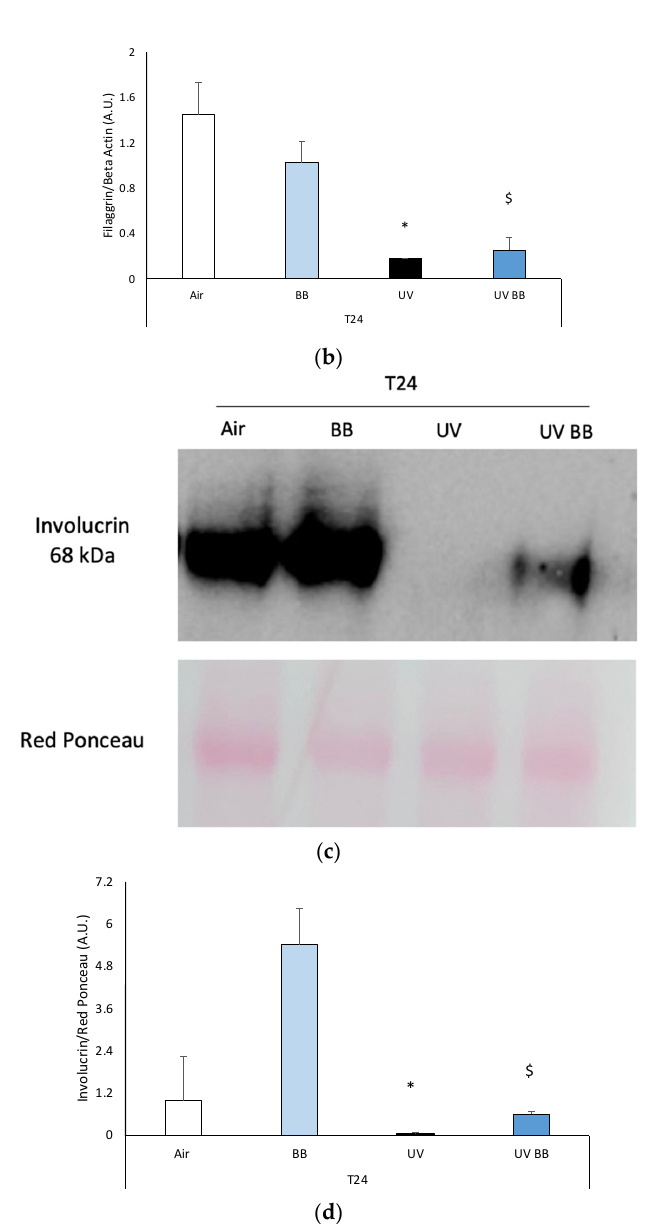
Figure 5. Skin exposure to UV impairs skin barrier functions (filaggrin, involucrin), which were normalized by the pre-treatment with BB extract. Ex vivo human skin biopsies were untreated or pre-treated with BB and then exposed to 200 mJ of UVA/UVB, then, filaggrin and involucrin protein levels were evaluated. ( a ) Filaggrin protein levels measured via Western blot assay at 24 h (T24) upon UV exposure. ( b ) Relative quantification of filaggrin protein levels measured by ImageJ. ( c ) Involucrin protein levels measured via Western blot assay at 24 h (T24) upon UV exposure. ( d ) Relative quantification of involucrin protein levels measured by ImageJ. Data are expressed as arbitrary units (average of three independent experiments), * p < 0.05 Air vs. UV; $ p < 0.05 UV vs. UV BB by ANOVA.